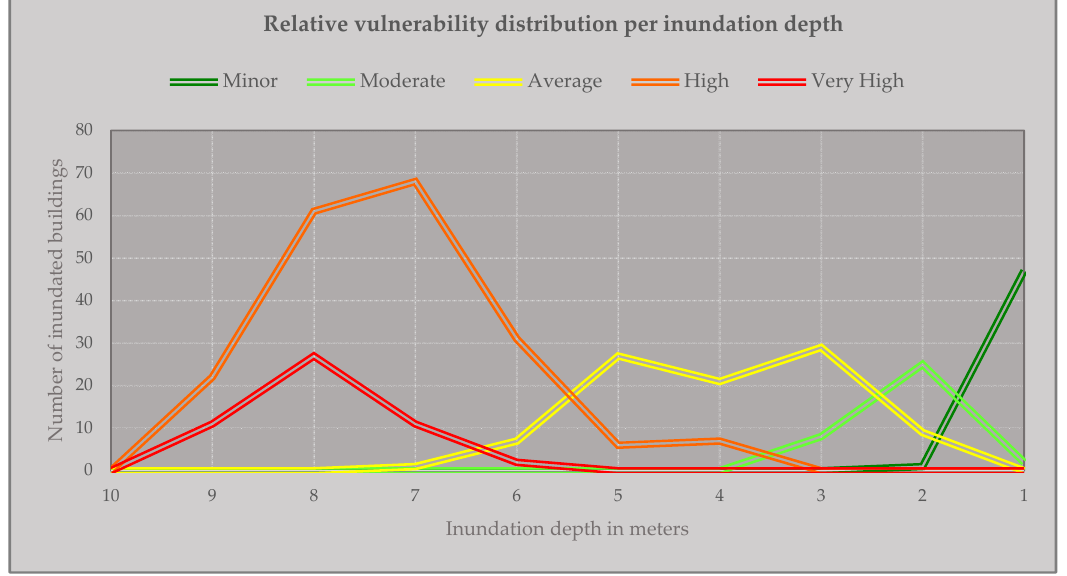
Figure 12. Diagram depicting the building vulnerability level in relation to inundation depth. Value 10 on the x-axis represents the coastline and value 1 represents the end of the inundation zone.